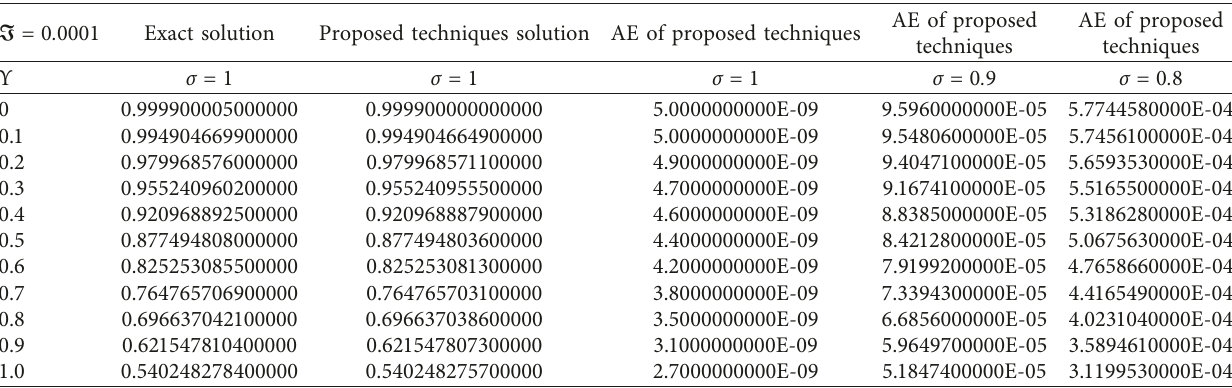
Figure 6: Exact solution, analytical solution, absolute error. and various fractional order solution for φ ( ξ , I ) and ] ( ξ , I ) of problem 3. Table 6: Comparison of the proposed method and exact results with absolute error (AE) at various fractional order for φ ( ξ , I ) and ] ( ξ , I ) of problem